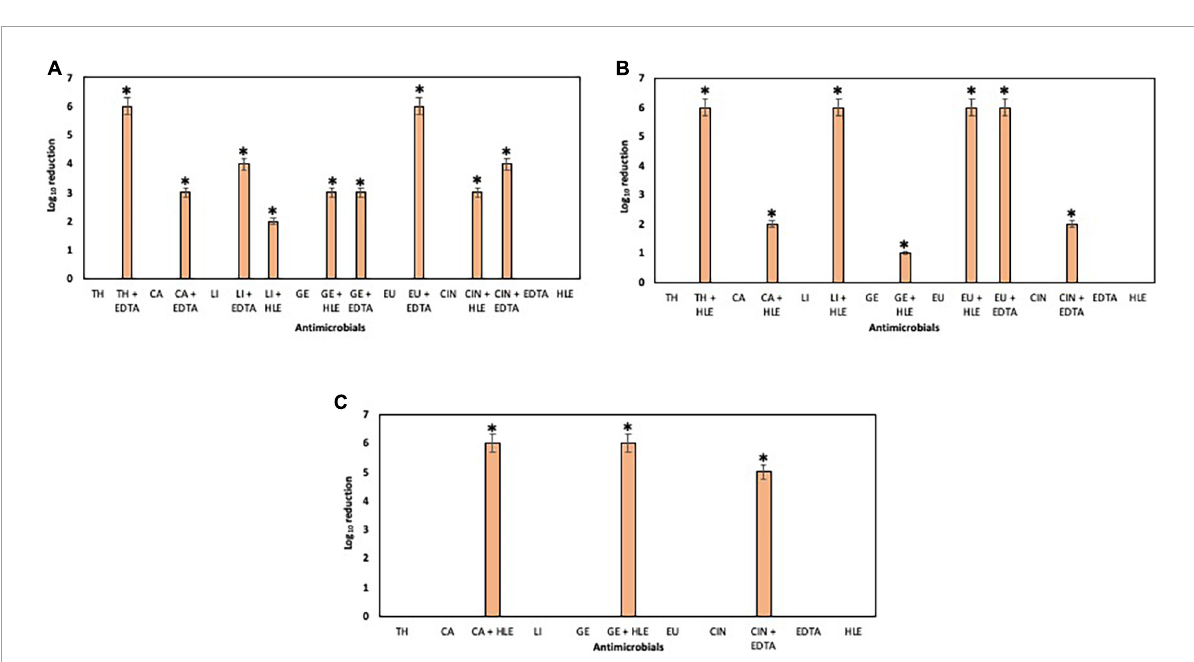
resistance profiles may depend on the species and strain tested. Overall, the high prevalence of phenotypic resistance to beta-lactams (ampicillin and cefuroxime) and